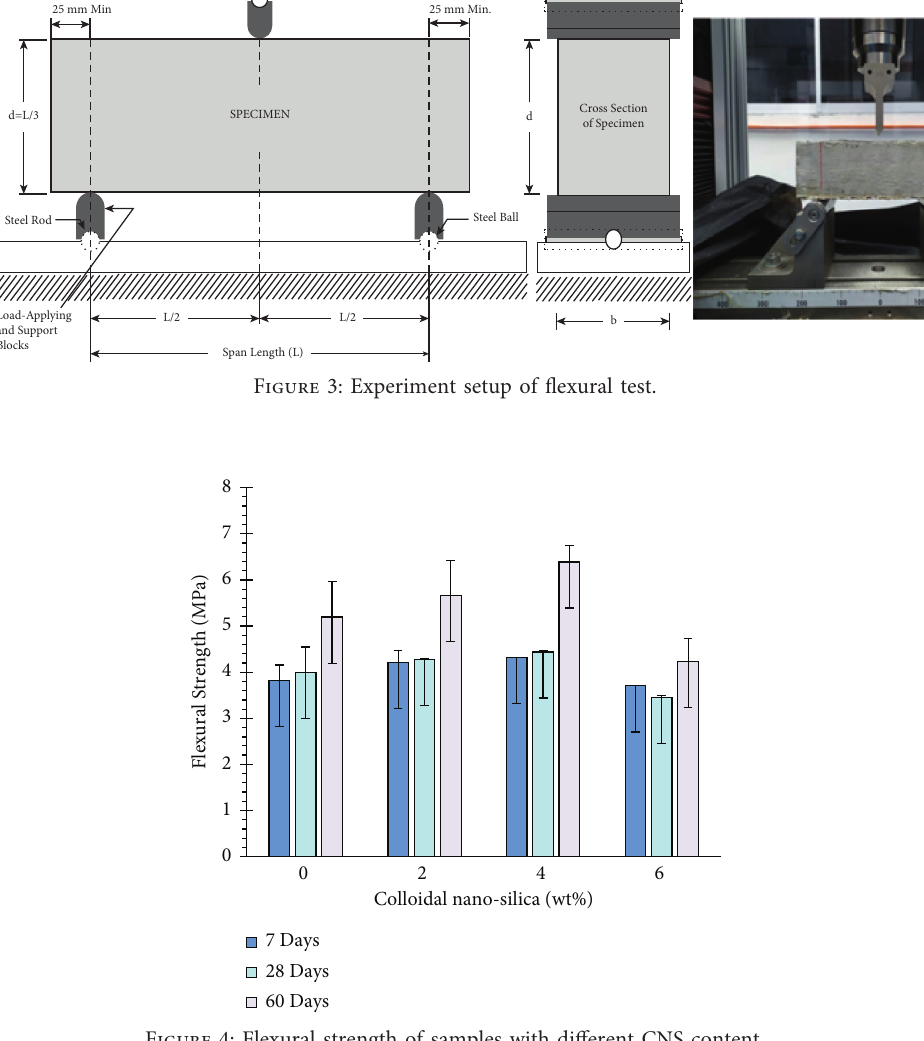
Figure 4: Flexural strength of samples with different CNS content.